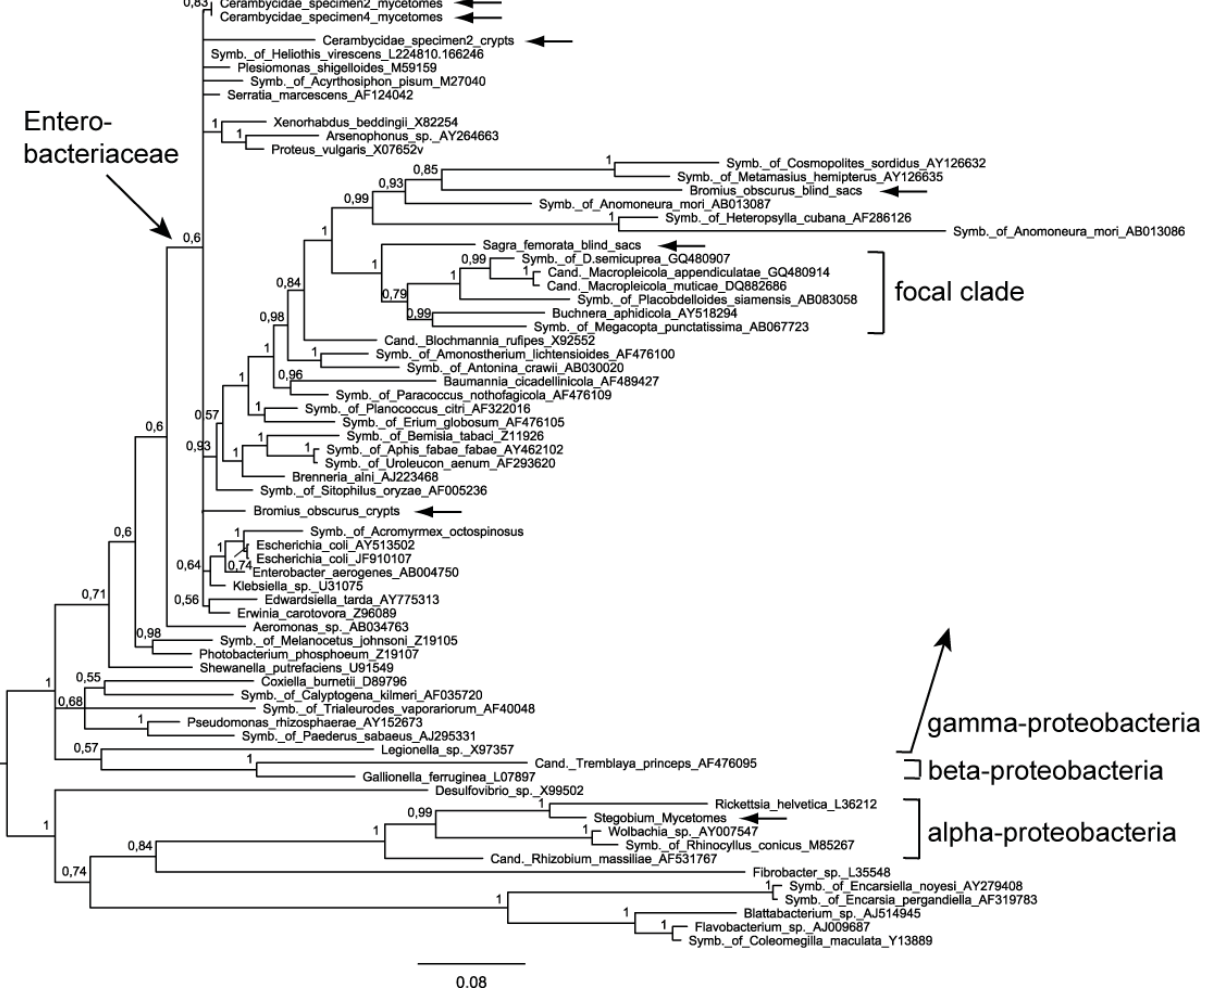
Figure 3. Phylogenetic position of the bacteria analyzed in the present study (horizontal arrows), based on partial 16S rRNA sequences (dataset ‘bacterial phylogeny’). The tree was constructed using MrBayes. Posterior probabilities are given to the upper left of each node. For further explanations, see Figure